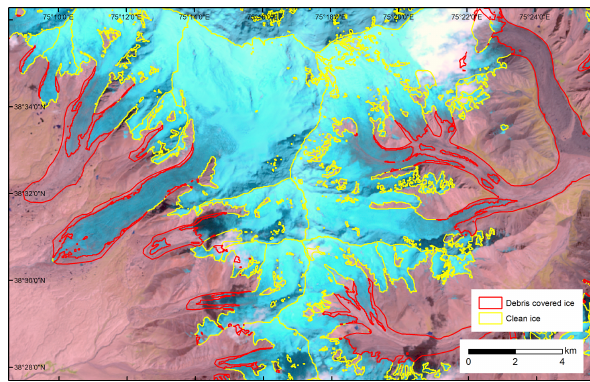
Figure 6. Debris cover classification in the Kongur Shan in the east- ern